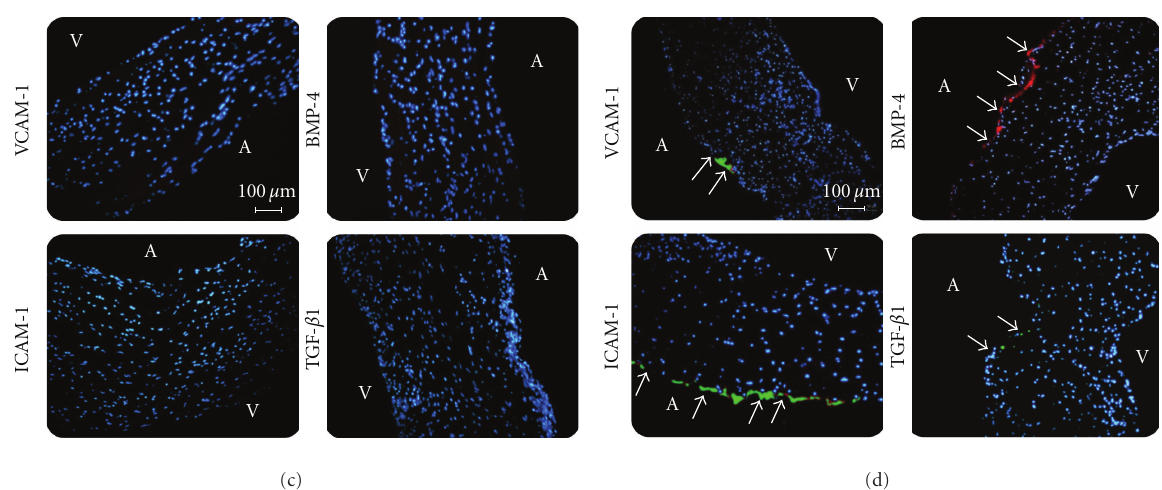
Figure 4: Inflammatory response of AV leaflets after exposure of the fibrosa to normal (native) and altered (ventricular) shear stress: immunostaining (blue: cell nuclei; green: ICAM-1/VCAM-1/TGF- β 1; red: BMP-4); quantitative results ( ∗ P < . 05 versus